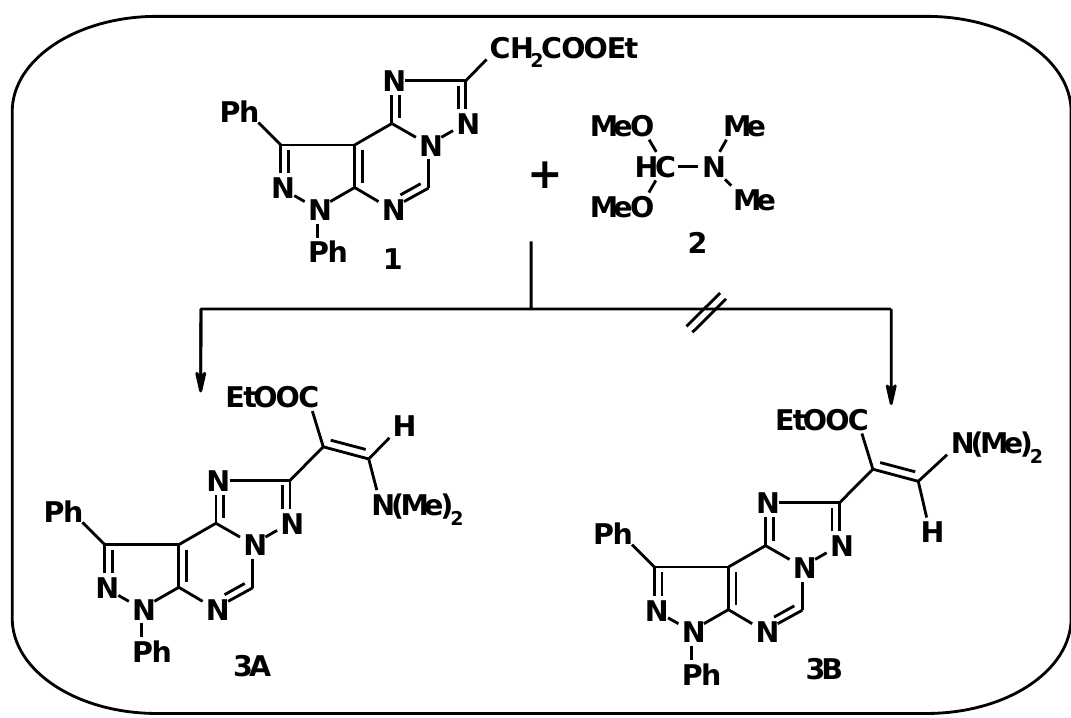
Scheme 1. Synthesis of the title compound ( 3A